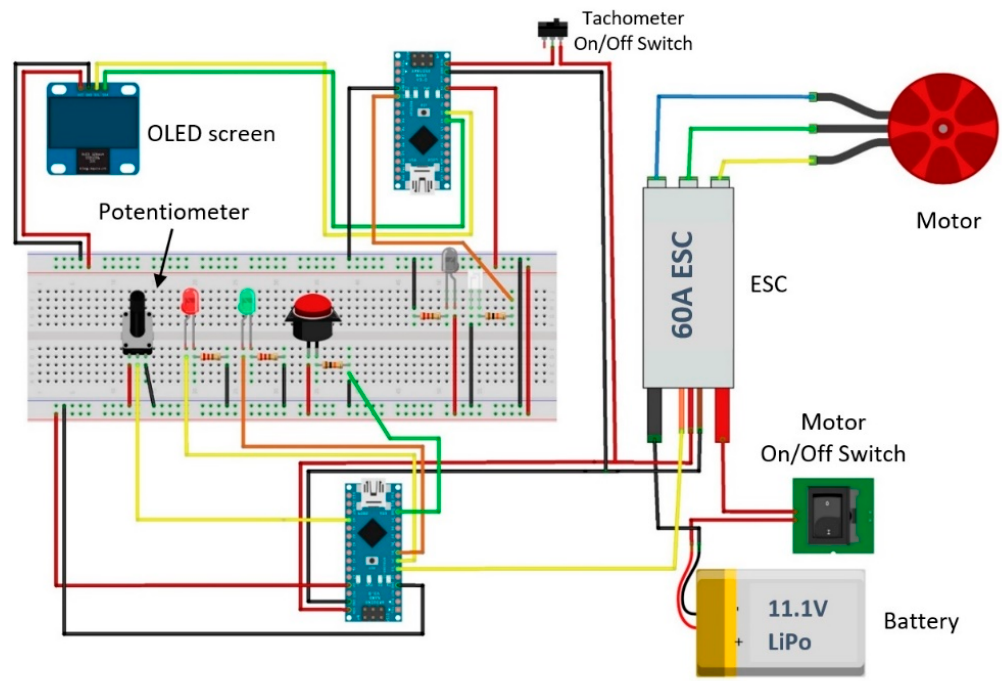
Figure 5. Drive system schematic diagram.